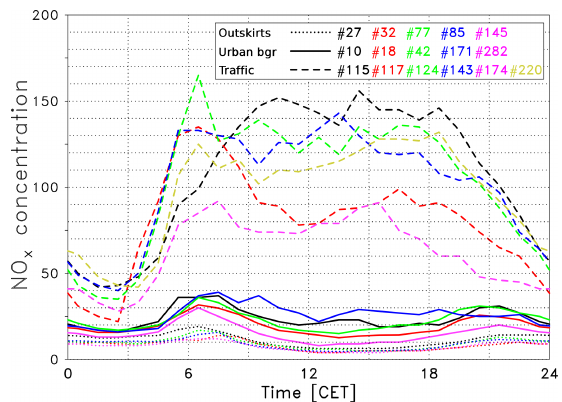
Figure 11. Diurnal cycle of NO x concentration (in µgm − 3 ) at all BLUME stations: five at the outskirts of Berlin (dotted lines), five urban background stations (solid) and six traffic stations (dashed) as indicated in the legend (see also Table 1). Medians of concentrations are